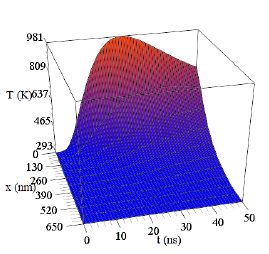
Figure 7. Temperature profile T ( x , t ) for F 0 = 80 mJ / cm 2 .